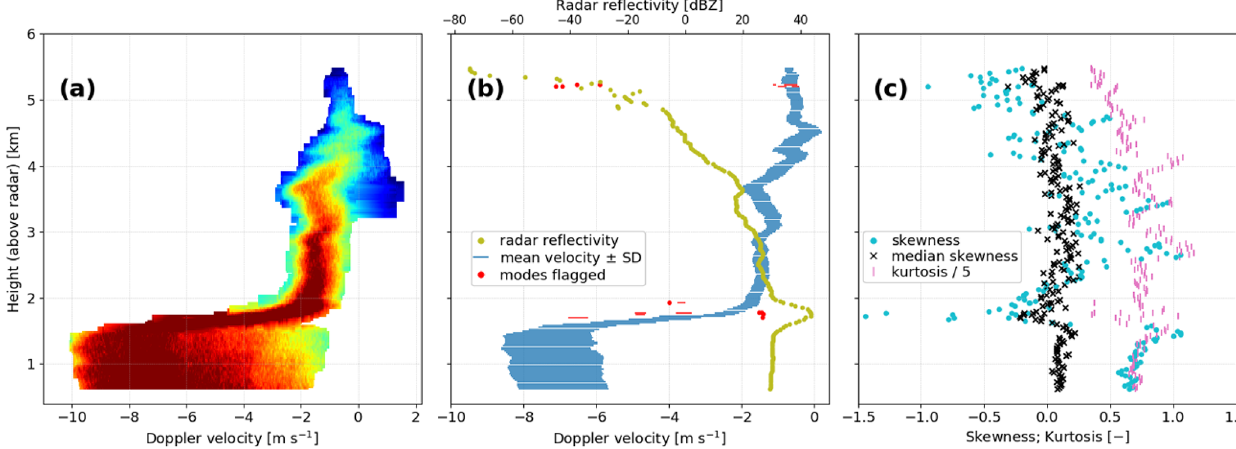
Figure 11. Summary of analysis results for a birdbath scan recorded in stratiform rain at DWD’s Essen (ESS) radar in October 2021 (data timestamp: 25 October 2021, 16:54:12UTC), analogous to Figs. 8 and